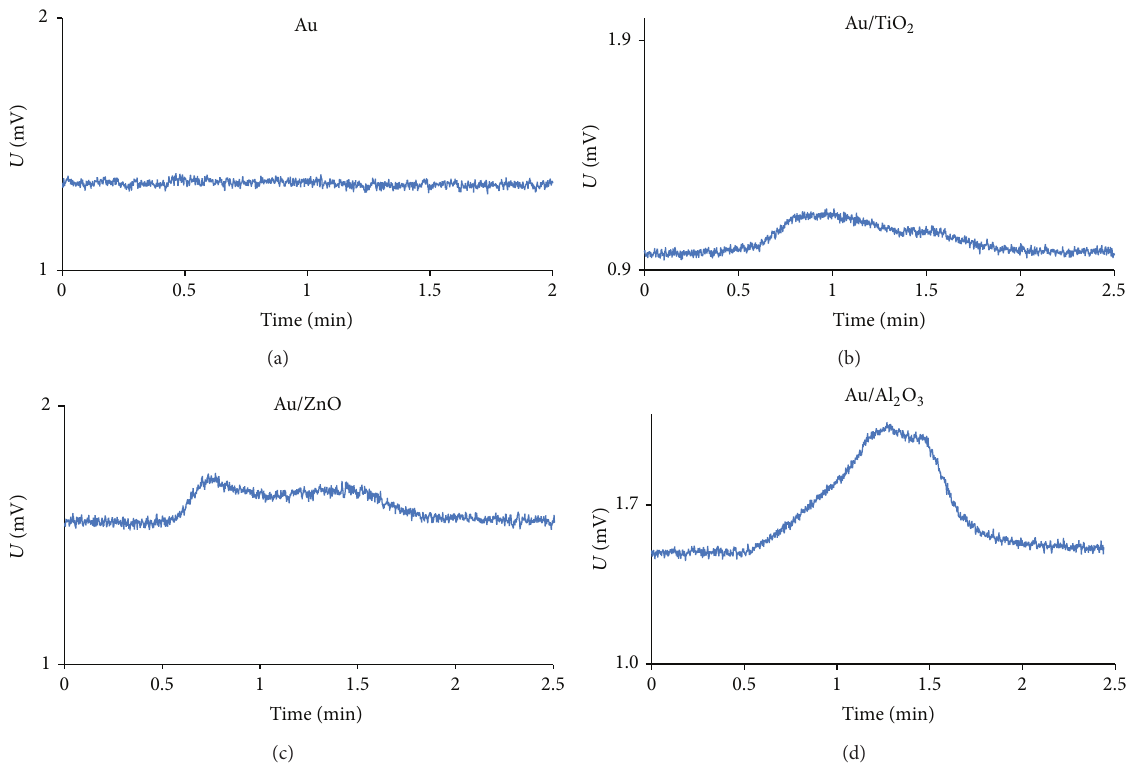
Figure 7: Examples of baseline obtained after the desorption of Hg from the different